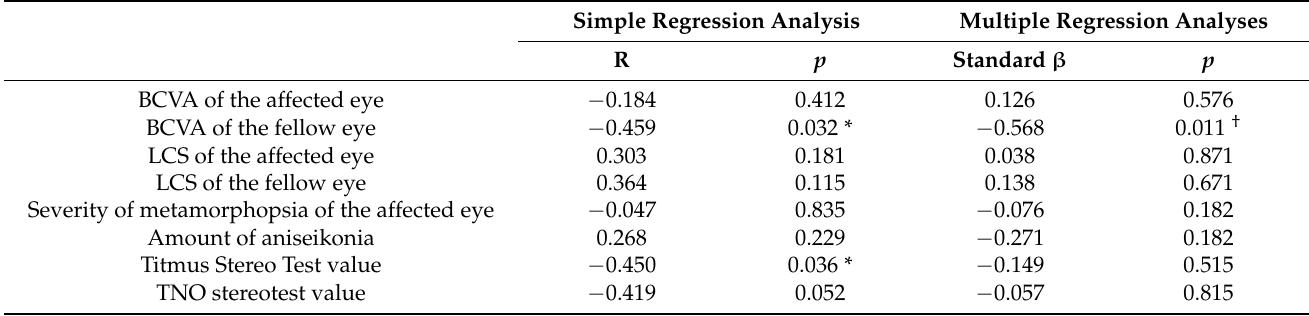
Table 3. Visual functions affecting VFQ-25 composite score at baseline. Simple Regression